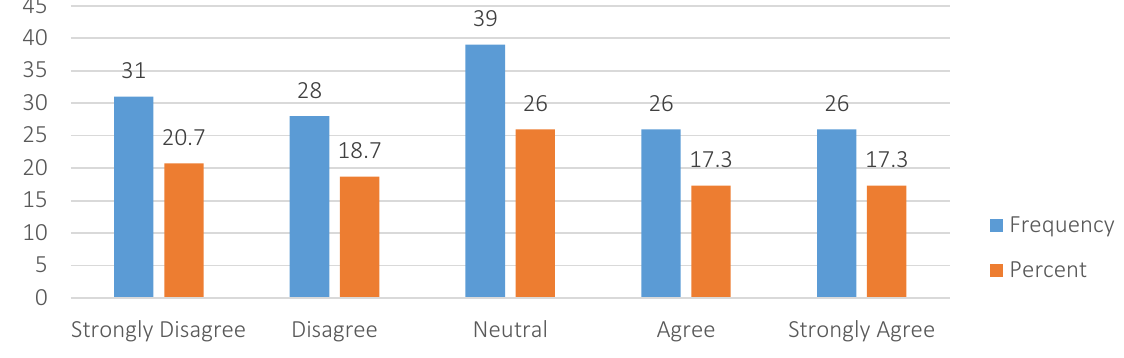
Figure 4. Lack of government business incubation influences the adoption of MAPs